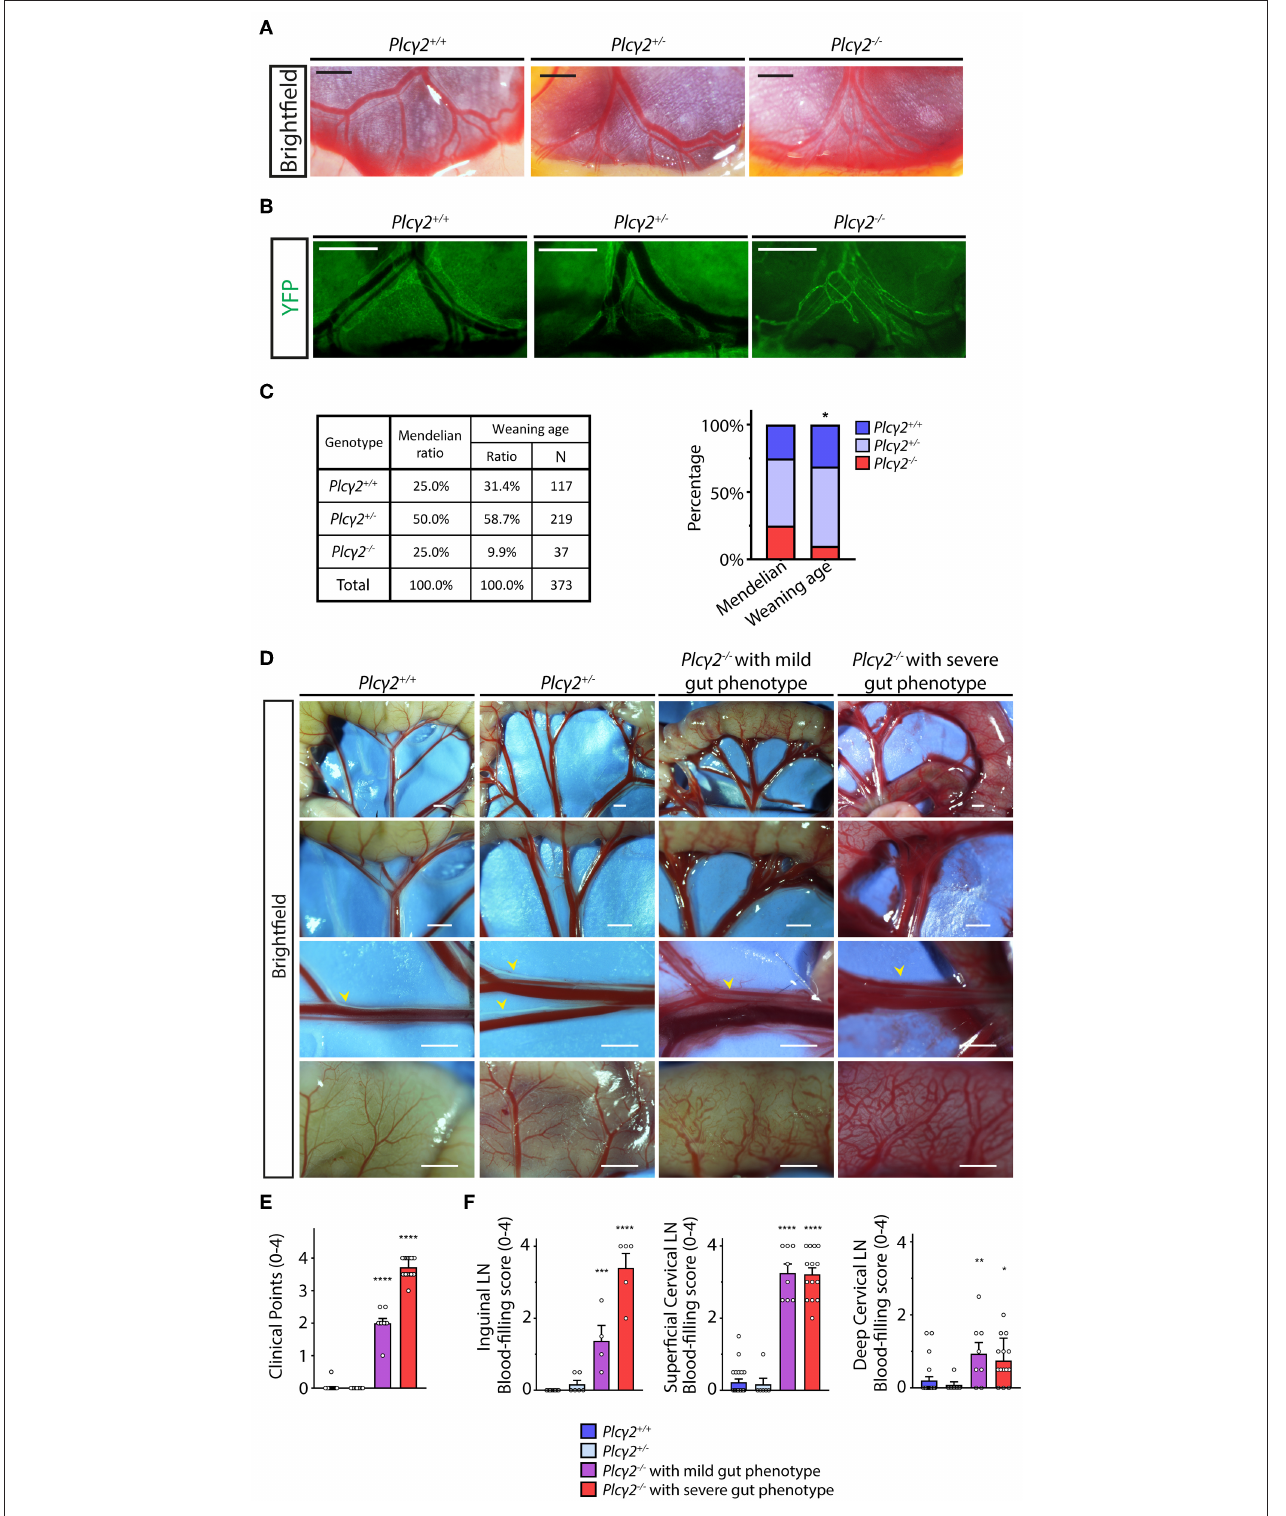
FIGURE 6 | Characterization of the lymphatic phenotype of Plc γ 2 − / − and littermate control mice. (A) Lymphatic and blood vessels are shown in the wall of small intestine and mesentery of Plc γ 2 + / + , Plc γ 2 + / − and Plc γ 2 − / − embryos at E19.5 ( n = 6 for Plc γ 2 + / + embryos; n = 7 for Plc γ 2 + / − embryos, n = 6